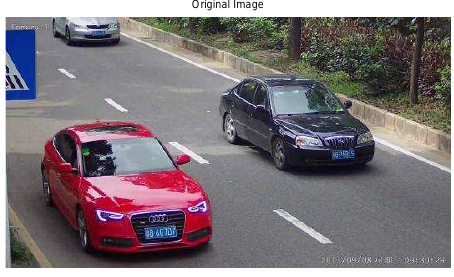
Fig. 7 Cars on the road (1).